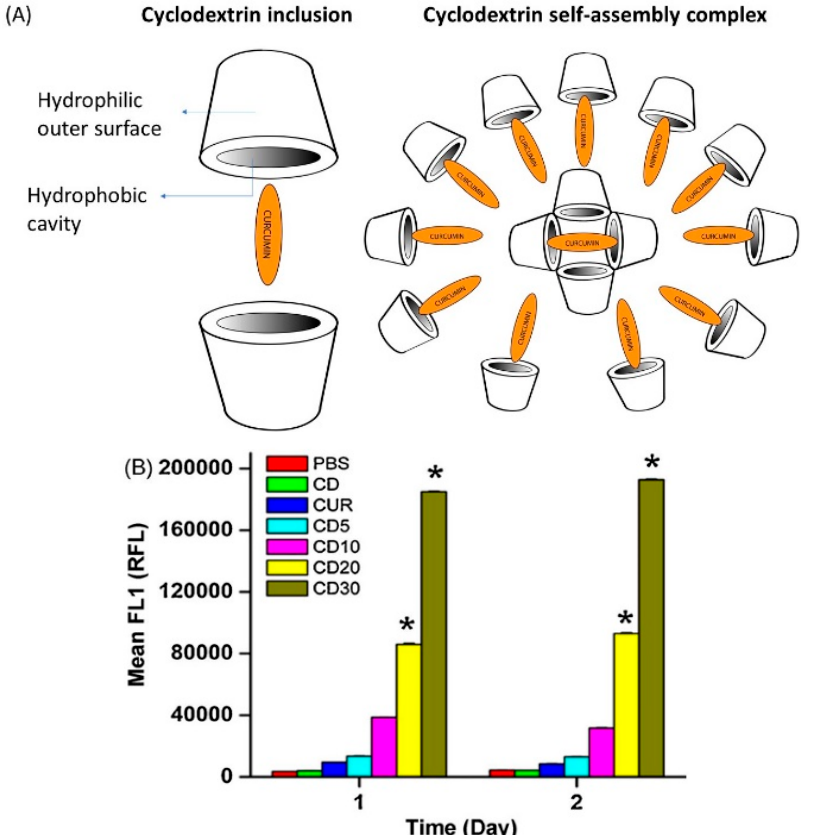
Figure 5. ( A ) Schematic structure of cyclodextrin–curcumin (CD–CUR) inclusion and self-assembled complexes ( B ) Fluorescence-activated cell sorting (FACS) analysis for cellular uptake of curcumin and different CD–CUR (CD5, CD10, CD20, and CD30) inclusion complexes treated in DU145 prostate cancer. * p < 0.05 represents significant difference from the curcumin uptake. Reprinted from Yallapu et al. [86] with permission from the copyright holder Elsevier.